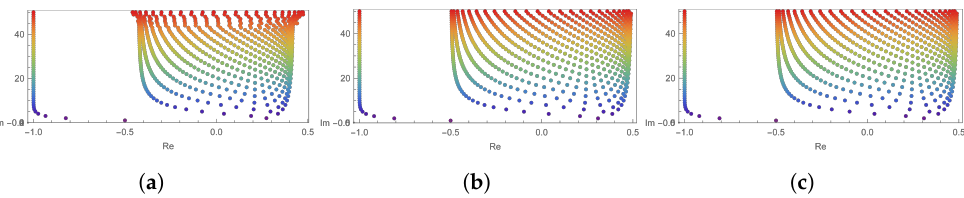
Figure 3. Approximate roots of S n , q ( x ) with 0 ≤ n ≤ 50: ( a ) q = 0.01, ( b ) q = 0.001, ( c ) q =